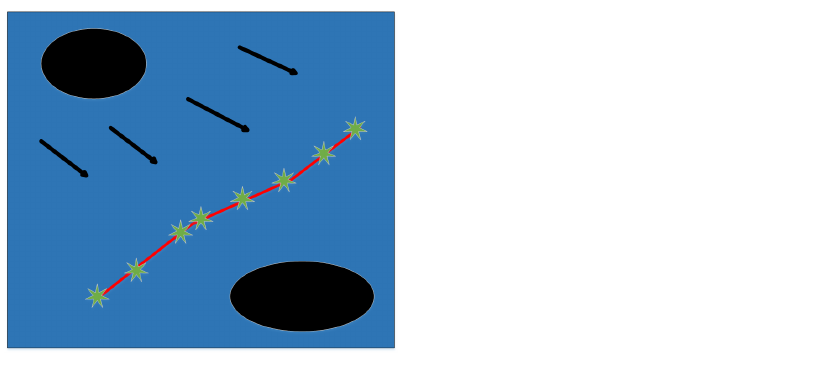
Figure 6. The path with waypoints on the ocean water surface containing obstacles and ocean